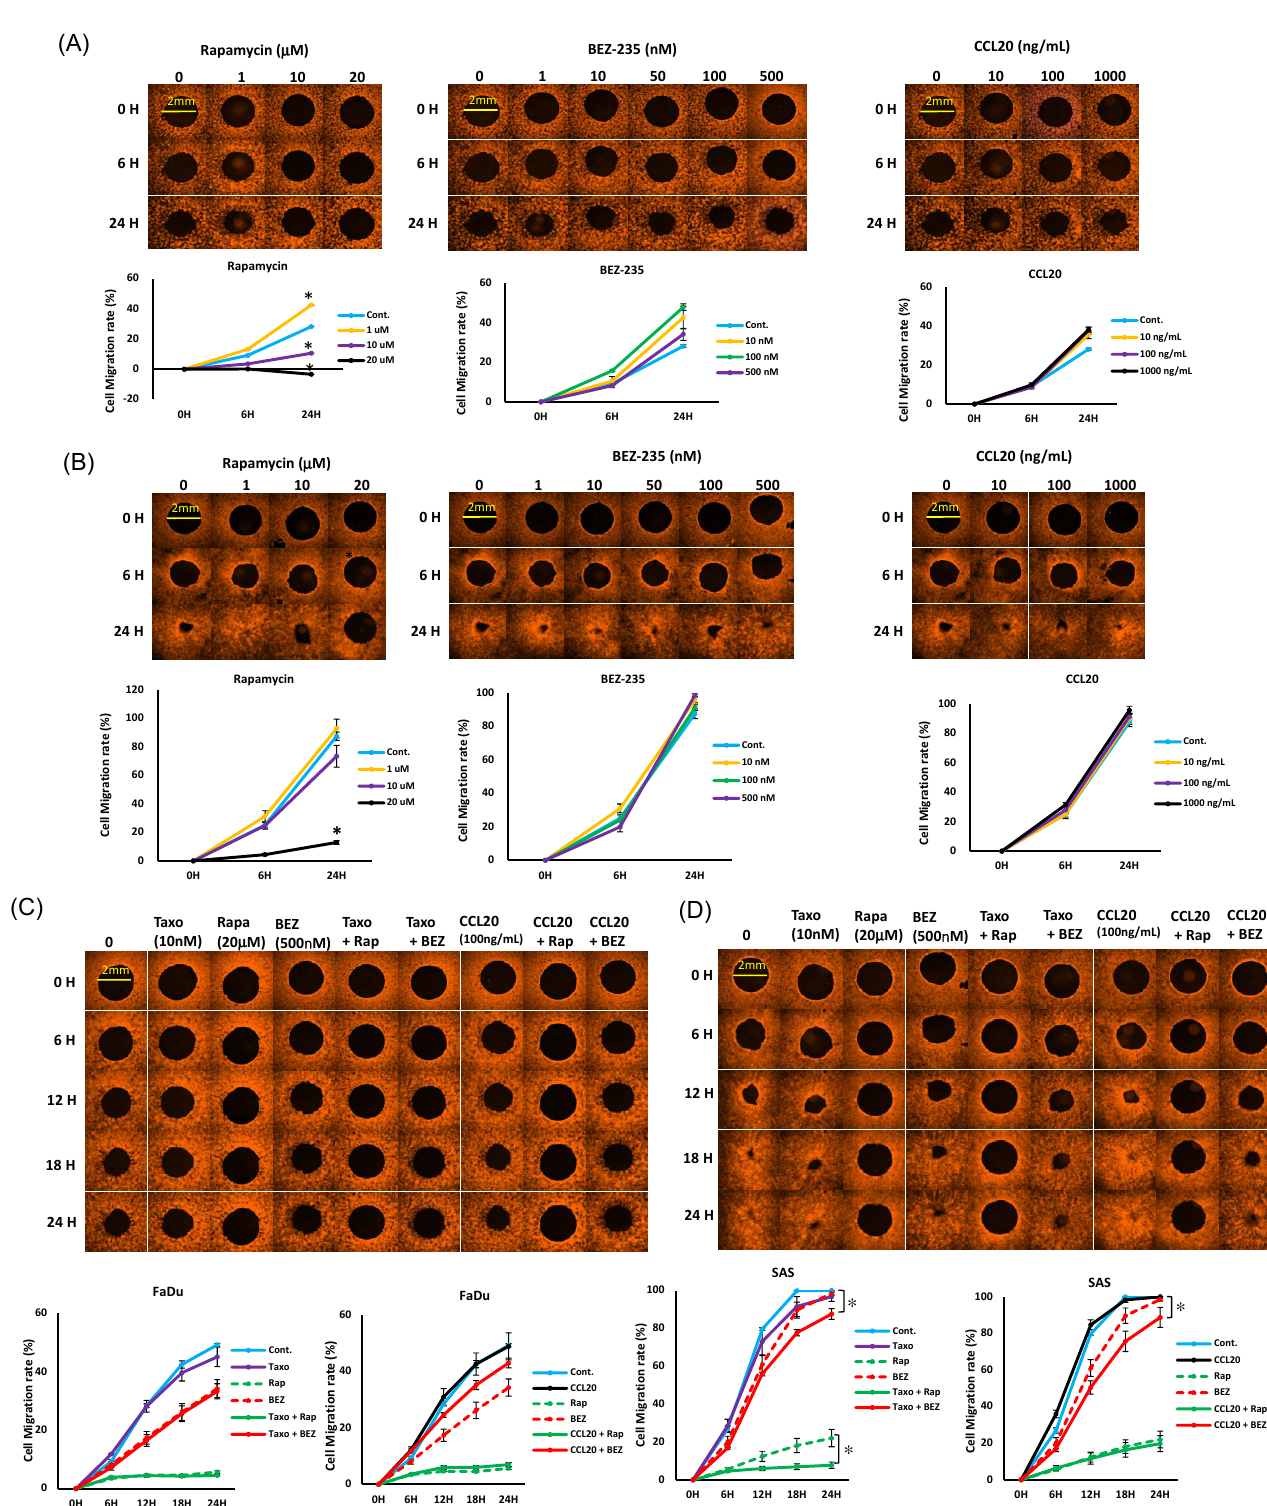
Figure 6. Effect on cell migration of mTOR inhibitors combined with docetaxel or CCL-20. ( A ) FaDu and ( B ) SAS cells were treated with rapamycin (1 to 20 µ M), BEZ235 (1 nM to 10 µ M), and CCL-20 (0.01 to 1 µ g/mL) for 6 to 24 h, and ( C , D ) combined with docetaxel or CCL-20 for 6 to 24 h. Cell migration was determined by Oris™ Cell Migration Assay. Data are expressed as the mean ± SEM ( n = 6). * p <